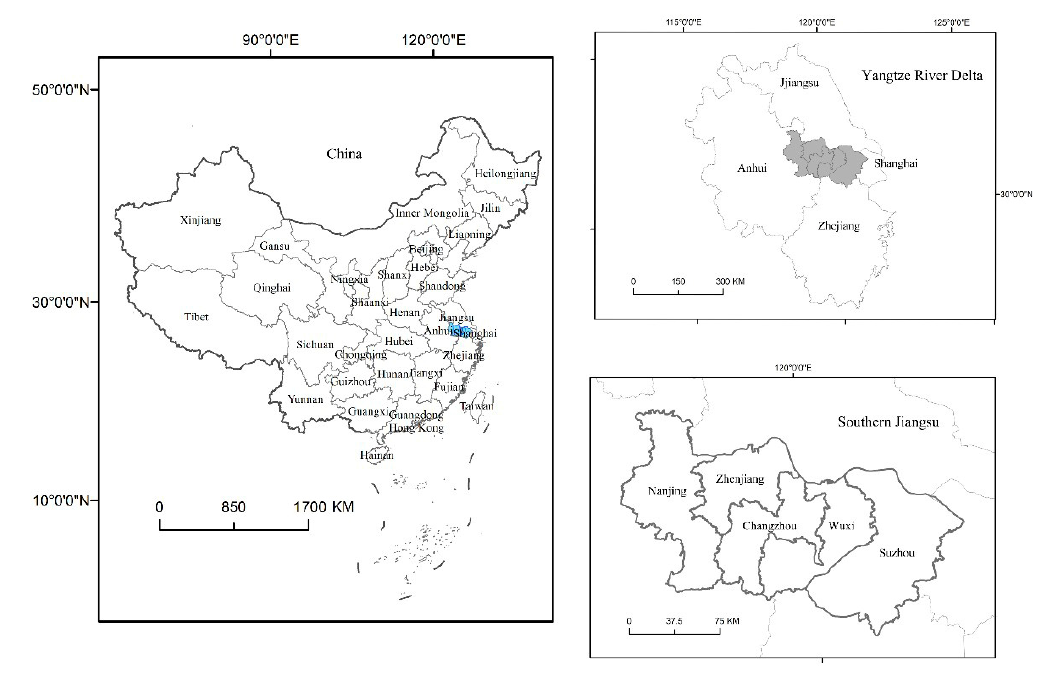
Figure 2. Study Figure 2. Study area.